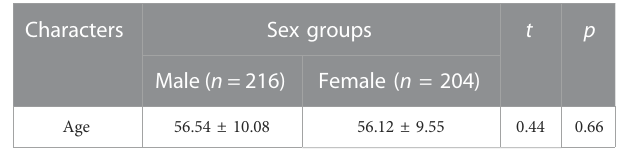
TABLE 3 Distribution characteristics of left inferior pulmonary